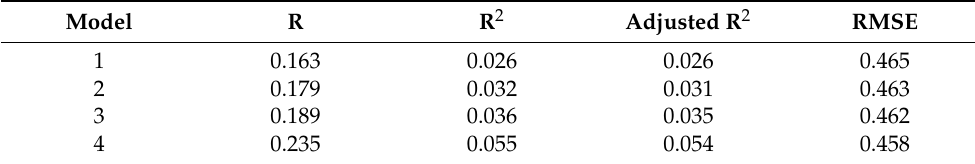
Table 4. Model fit measures.